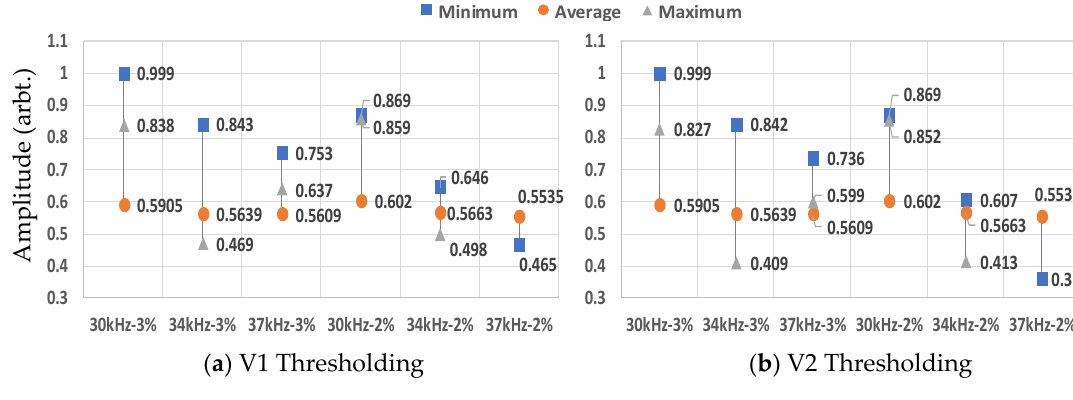
Figure 13. Limits achieved using method three in the first set of tests.